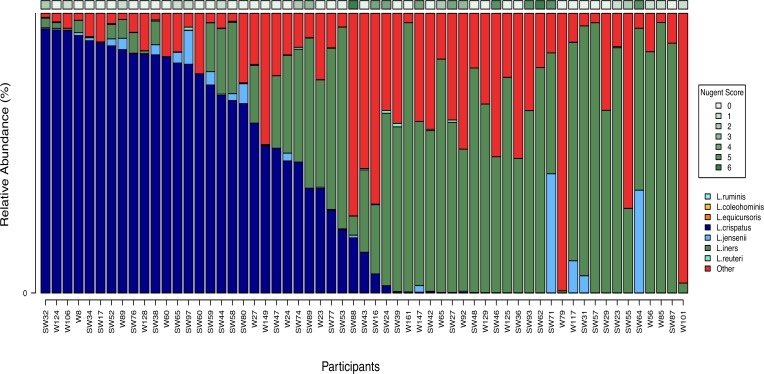
Relative abundance of the different vaginal bacterial species in each healthy adolescent.L. crispatus is shown in dark blue, L. iners in dark green, L. ruminis, L. jensenii and L. reuteri in shades of light blue, L. equicursoris/delbrueckii in dark orange and L. coleohominis is shown in light orange, while non-Lactobacillus spp. are shown in red for each participant. The Nugent score is shown above the figure in green.